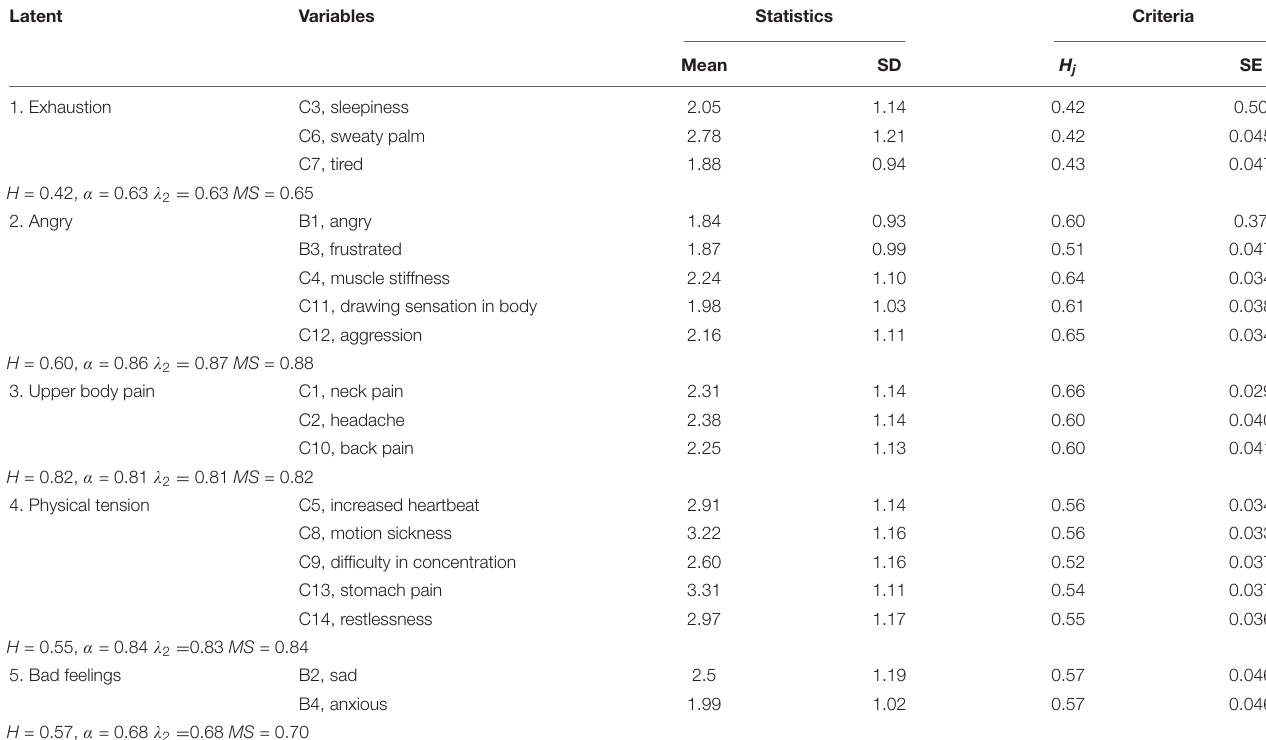
TABLE 2 | Statistics and scalability summary of scales with related